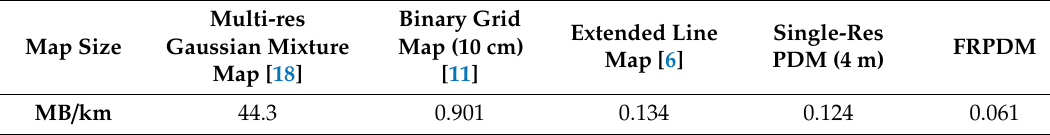
Table 2. Comparison of map